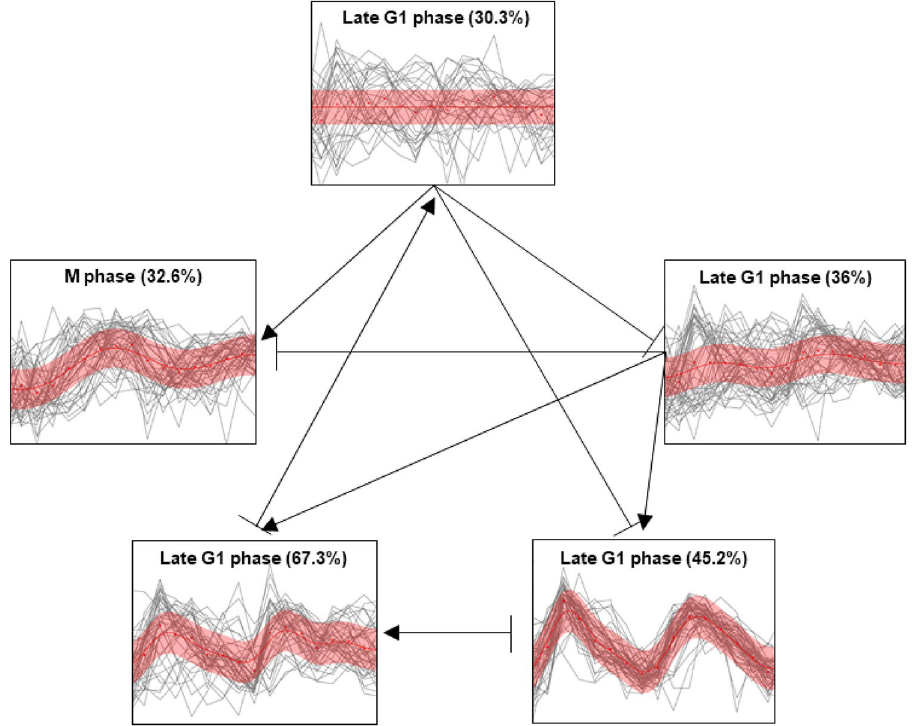
Figure 6. Cluster network of cell cycle dataset inferred by ClusterNet 19 . Triangle arrows and diamond arrows indicate activation and inhibition, respectively. Self-regulations are omitted. Each cluster is labeled with corresponding cell cycle phase based on the true cluster labels of genes. The percentages of genes belonging to the labeled cell cycle phase are marked for each